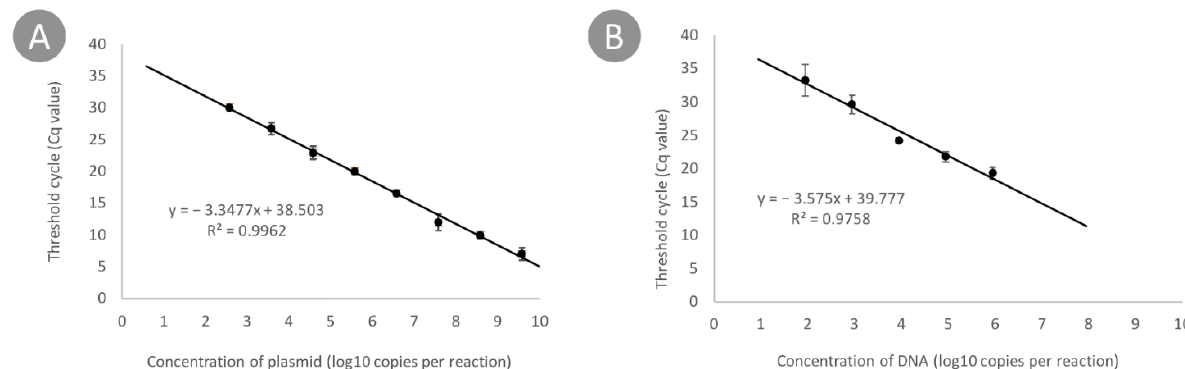
Figure 4. Standard curves showing the relationship between Cq and the quantity of plasmid DNA ( A ) genomic DNA of the P. atrosepticum SCRI1043 ( B ).